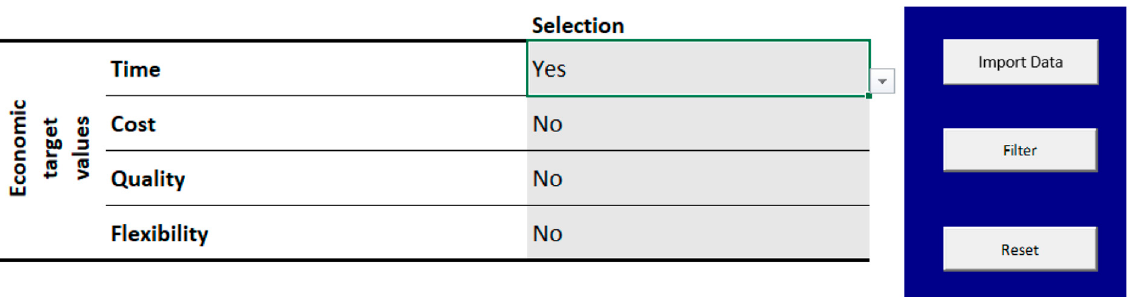
Figure 12. Implemented filter function for the case-specific selection of effects of modularization (here using the example of the four economic target values).